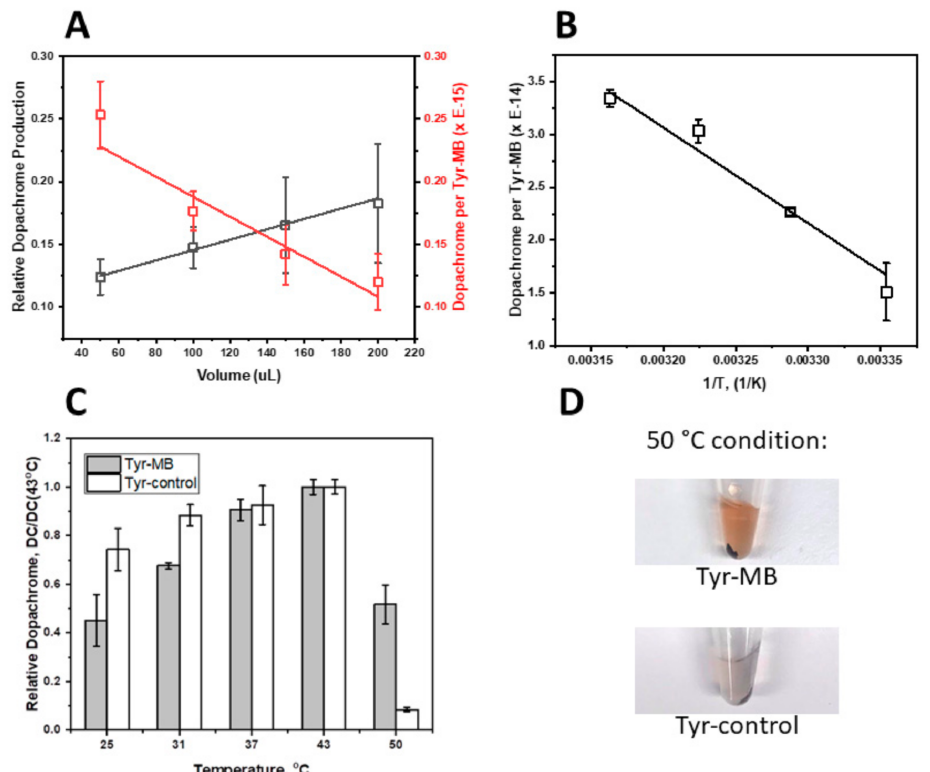
Figure 2. Relative dopachrome production and dopachrome formation per Tyr-MB complex. ( A ) dis- plays the magnetic bead volume-dependent experiment. Since higher volumes of MBs were used, the relative dopachrome production increased (black line, R 2 = 0.98). This measurement was attained by utilizing a ratio of the relative activity of Tyr-bound MB to the activity of the Tyr positive control. Regarding the red line on Panel A, the number of MBs were calculated for each condition (50, 100, 150, and 200 µ L) and then used to measure dopachrome production per Tyr-MB complex. Due to a decreased probability of each MB interacting with Tyr (100 µ L of 2.2 mg/mL constant for all conditions) at increasing volumes of MB, there was a decreasing trend of dopachrome formed per Tyr-MB complex (red line, Adj. R 2 = 0.84). ( B ) features the role of temperature in the production of dopachrome by Tyr-MB complex. The number of MBs were calculated for 100 µ L of MBs and divided from relative dopachrome formation (calculated as a ratio to the Tyr control as in Panel A) to show dopachrome production per Tyr-MB complex. As temperature increased, dopachrome formation per Tyr-MB complex increased (Adj. R 2 = 0.97). ( C ) shows the relative dopachrome production normalized to the maximum 43 ◦ C measurements for both the Tyr-MB and control and includes the 50 ◦ C condition. The Tyr in the Tyr-MB condition is stabilized by the MB and remains functional even at the highest temperature of 50 ◦ C. The bar graph displays a significant difference for relative dopachrome production at this temperature with the Tyr-MB condition being significantly higher than the control. When using Tyr-MB, dopachrome is still present as seen by the orange-brown color in ( D ) whereas most of the dopachrome has self-oxidized in the control condition, as seen by a clear color in Panel D. All experiments were performed in